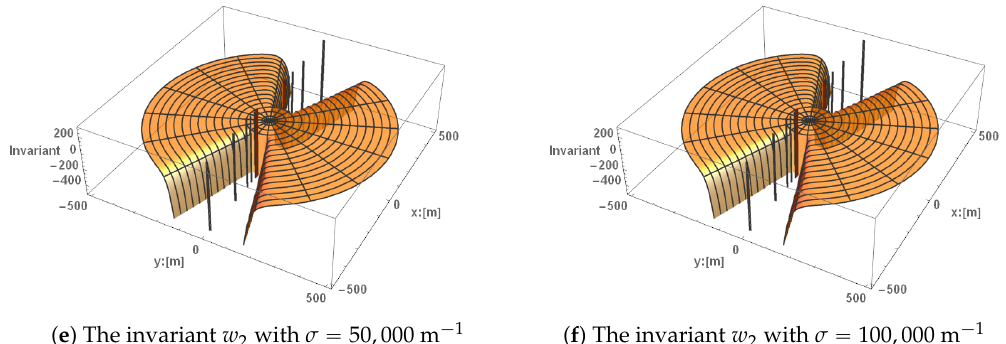
Figure A7. The warp bubble skin depth, σ , of the invariants r 1 , r 2 , and w 2 are plotted in the figures above. The other parameters were set to be ρ “ 100 m, a “ 1.0 m s ´ 2 , and t “ 1 s. The plots were rendered using Mathematica’s ® RevolutionPlot3D. It plots a function by rotating the function around the z-axis. The amount that the space diverges from being flat is represented by the invariant function’s magnitude, and its amount is labeled on the vertical axis. The x and y-axis are displayed on the plots, and they display the distance from a spaceship in the flat portion at the center of each figure. Each radial line in the left hand column corresponds to a distance of approximately 33 m. The constant portion to the right of the harbor is to the front of the warp bubble, and the constant portion to the left of the harbor is the back of the warp